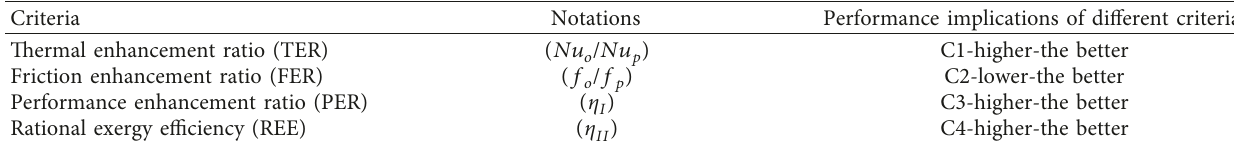
Figure 15: Multi-objective optimization of Pareto front ( η Table 8: Details of the different criteria.